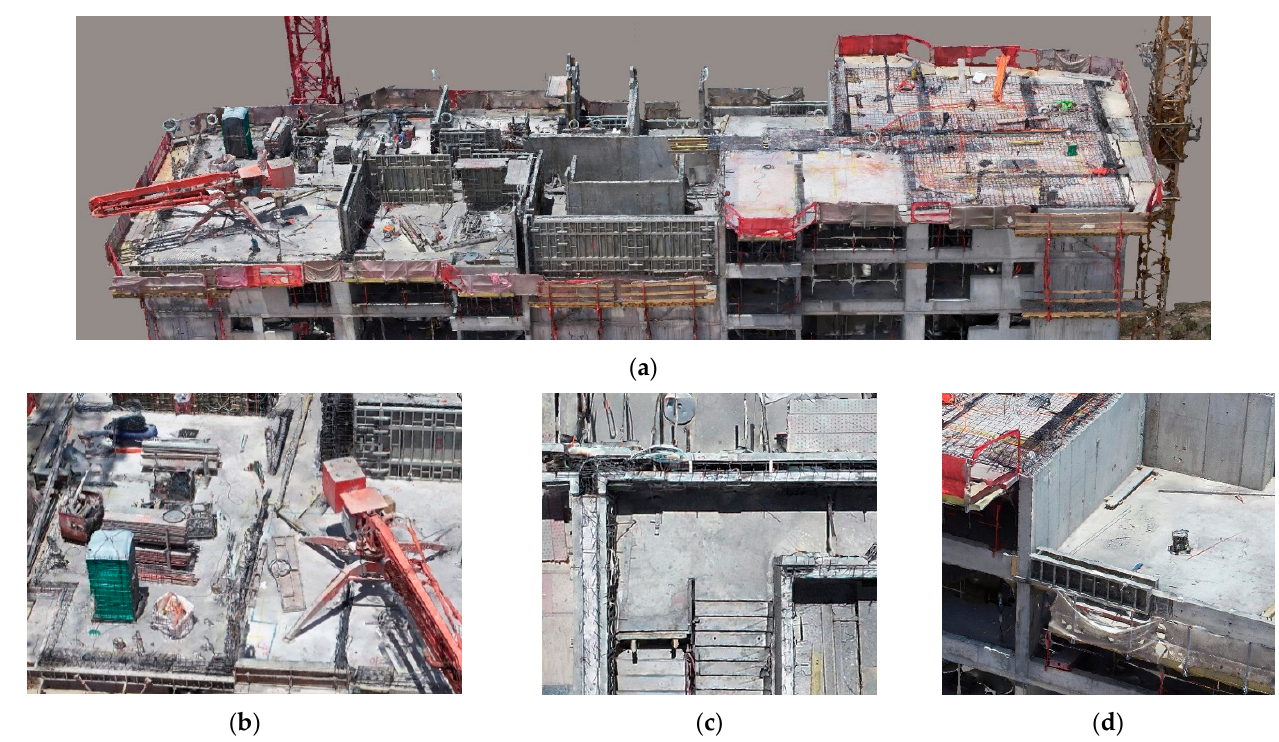
Figure 10. Different aspects observed in the reconstructed model: ( a ) Reality capture of the workspace of the case study, ( b ) stockpiling points and location of tools, ( c ) verification of concreting of elements, ( d ) potentially hazardous areas.